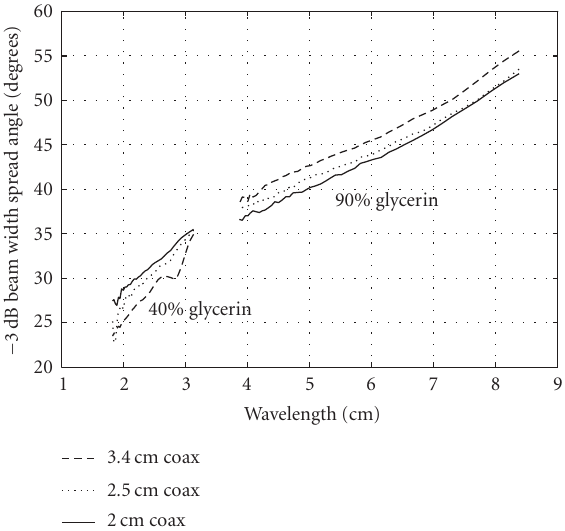
Figure 9: Beam widths for the 2.0, 2.5, and 3.4cm length monopole antennas as a function of the medium wavelength for the 90% and 40% glycerin: water